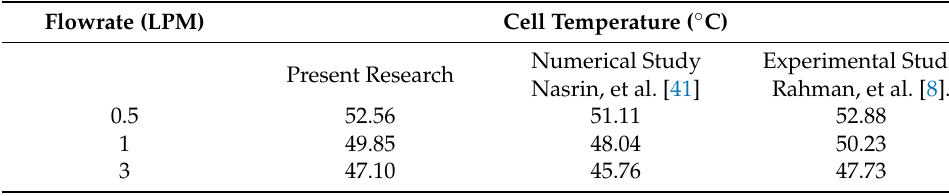
Table 6. Validation of average cell Temperature.